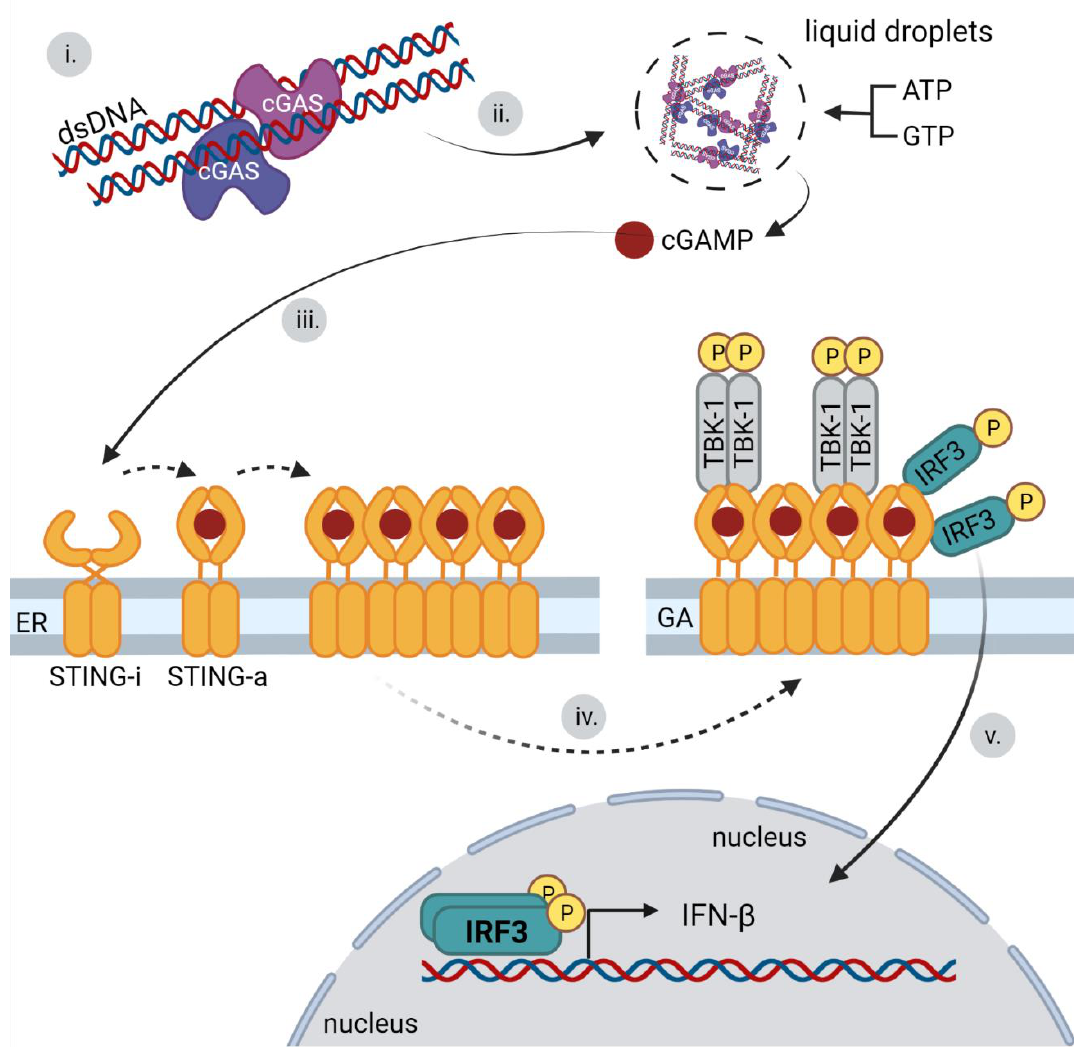
Figure 6. Crucial steps in the cGAS – STING pathway. (i) The binding of cGAS to dsDNA; (ii) cGAS dimers rearrange the dsDNA into a high affinity form suitable for binding other cGAS. The cGAS – DNA complex condensates and forms droplet structures where cGAS 2′ - 3′ cGAMP is produced (from ATP and GTP); (iii) 2′ - 3′ cGAMP binds to STING (STING inactive/STING-i), leading to its activation (STING-a). In detail, STING dimers oligomerize to linear tetramers; (iv) STING translocation